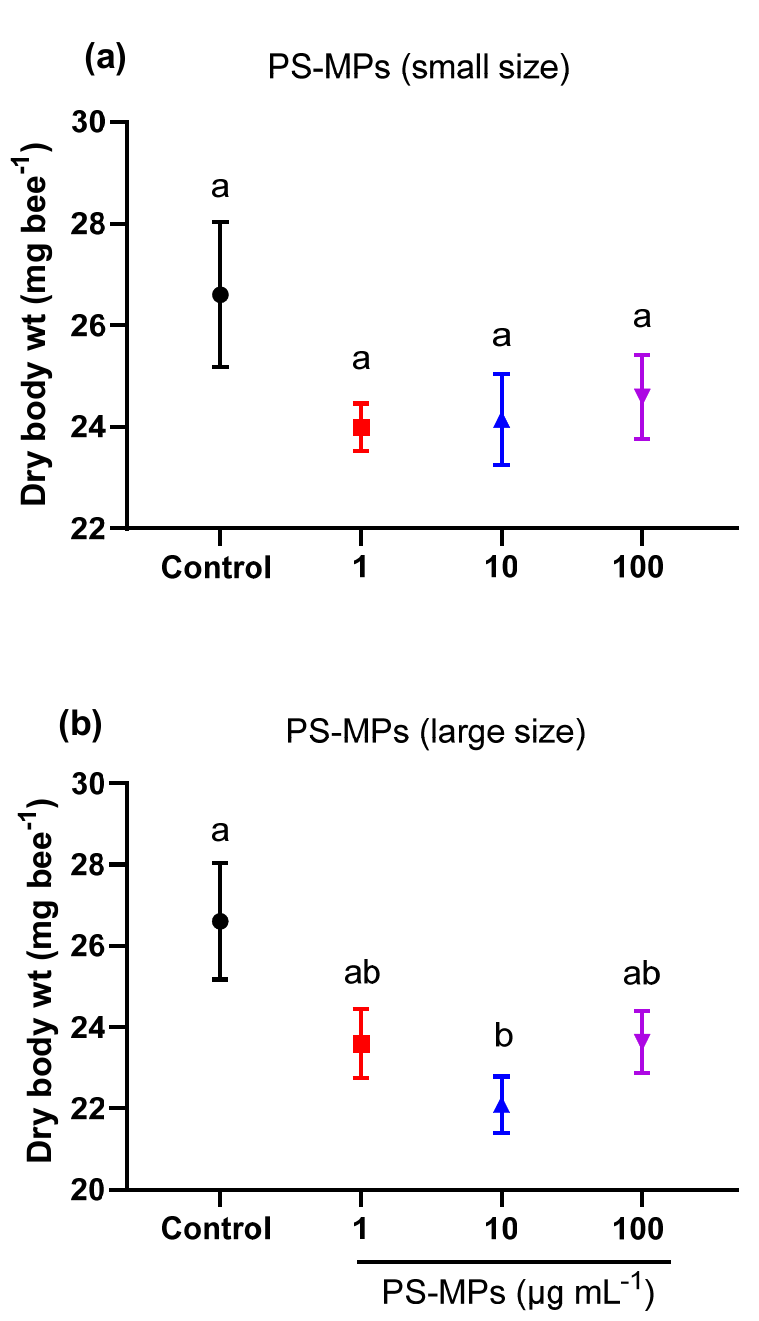
Figure 5. Average dry body weight ( ± SEM, n = 24) of honey bees that were chronically exposed for 14 days to various concentrations (1, 10, 100 µ g mL − 1 ) of either ( a ) small sized (27 ± 17 µ m) or ( b ) large sized (93 ± 25 µ m) PS-MP fragments. Controls received the same treatments devoid of PS-MP fragments. Different lowercase letters indicate statistically significant differences between treatments (one-way ANOVA with Tukey’s post hoc test, p < 0.05).